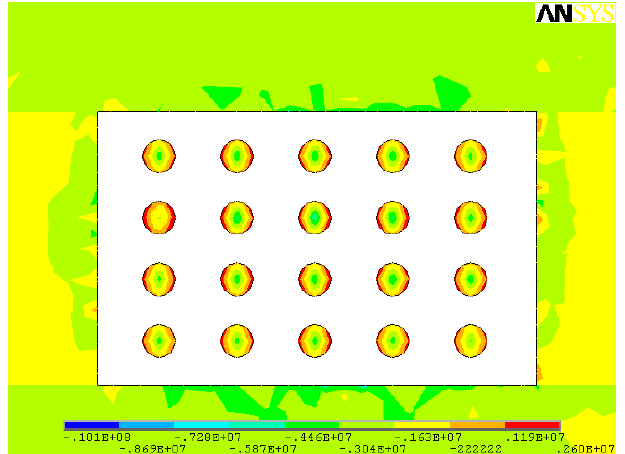
Figure 20. Maximum principal stress distribution in the middle of the pillar at 1480 mL of scheme 2 (parameters of scheme 2: stope height 2.5 m, pillar diameter 3 m, pillar spacing 6 m, pillar row spacing 8 m).